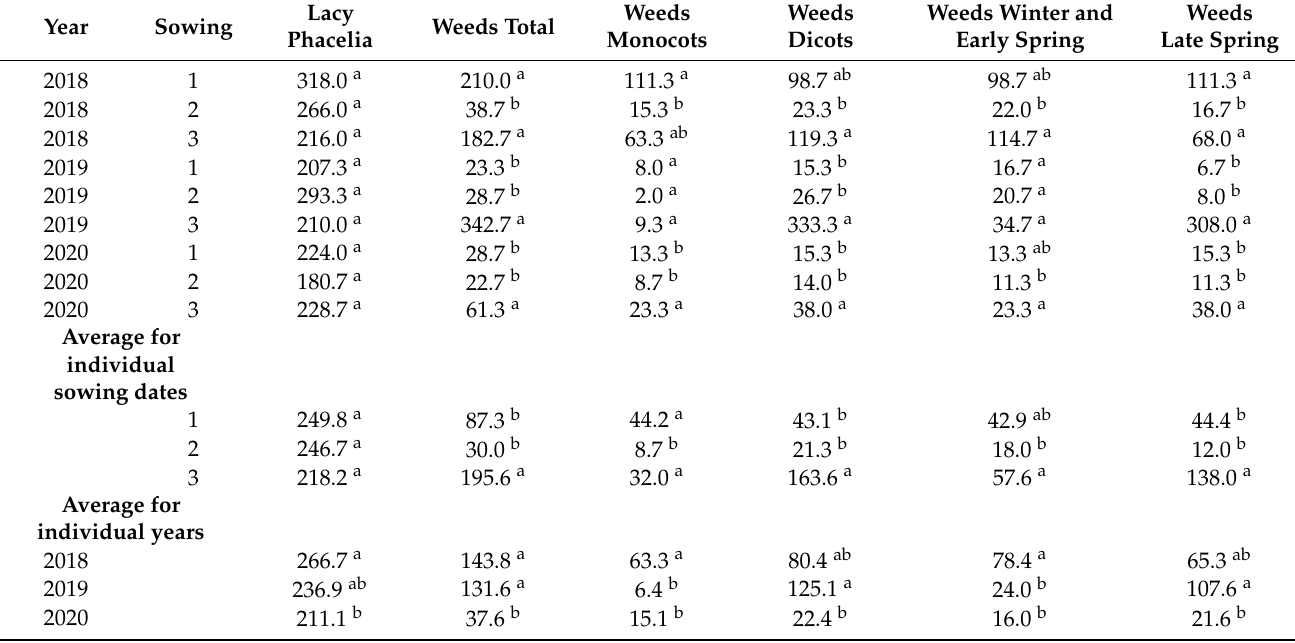
Table 2. Effect of sowing date on number of plants per m 2